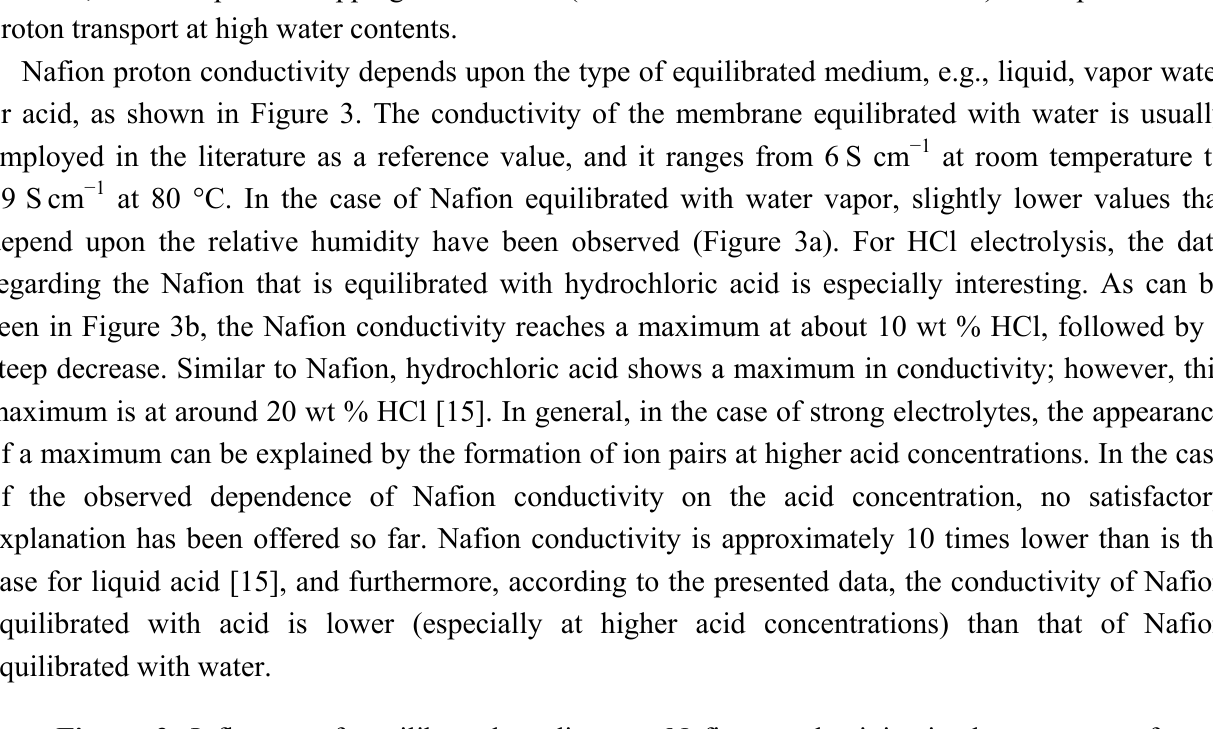
Figure 3. Influence of equilibrated medium on Nafion conductivity in the presence of ( a ) liquid water and vapor water at different relative humidities (RH) and ( b ) hydrochloric acid at different concentrations. Based on